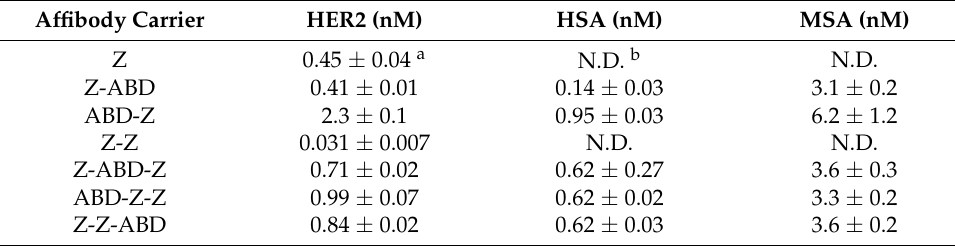
Table 2. The affinities between the constructs and HER2 or